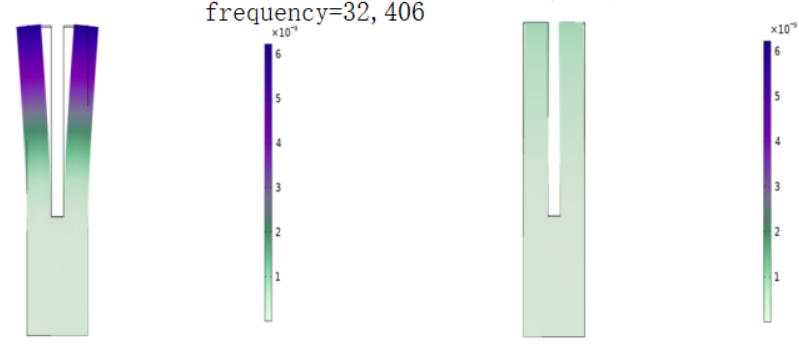
Figure 5. Vibration mode distribution characteristics.